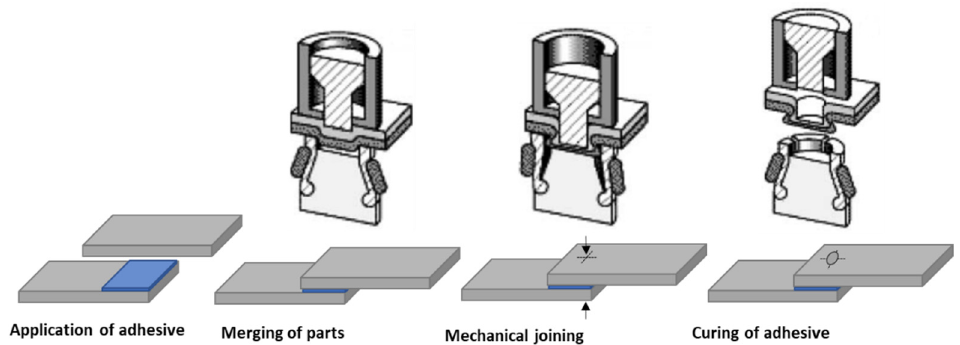
Figure 3. The principle of the clinch ‐ bonding technology based on [32].